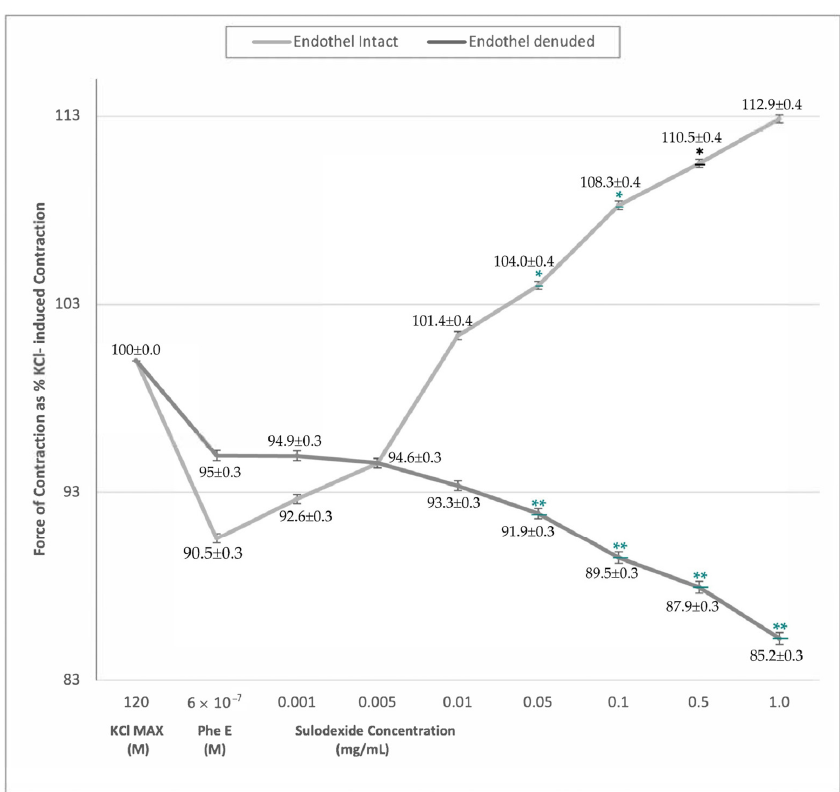
Figure 1. Sulodexide dose-response (0.005 mg/mL − 1 mg/mL) curves of phenylephrine pre-contracted endothelium-intact and denuded venous rings. Data presented as the percentage of maximum contraction (KCl MAX) induced by KCl (120 mM). * p < 0.05 within-group comparison ** p < 0.05 between-groups comparison.